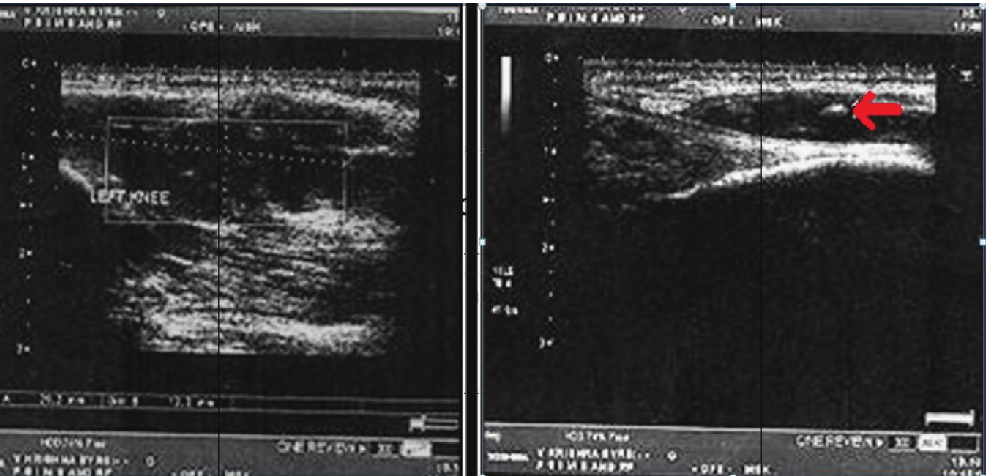
Figure 1: Ultrasound reveals a hypoechoic irregular mass located in the muscular plane with evidence of multiple calcific areas (marked with red arrow).